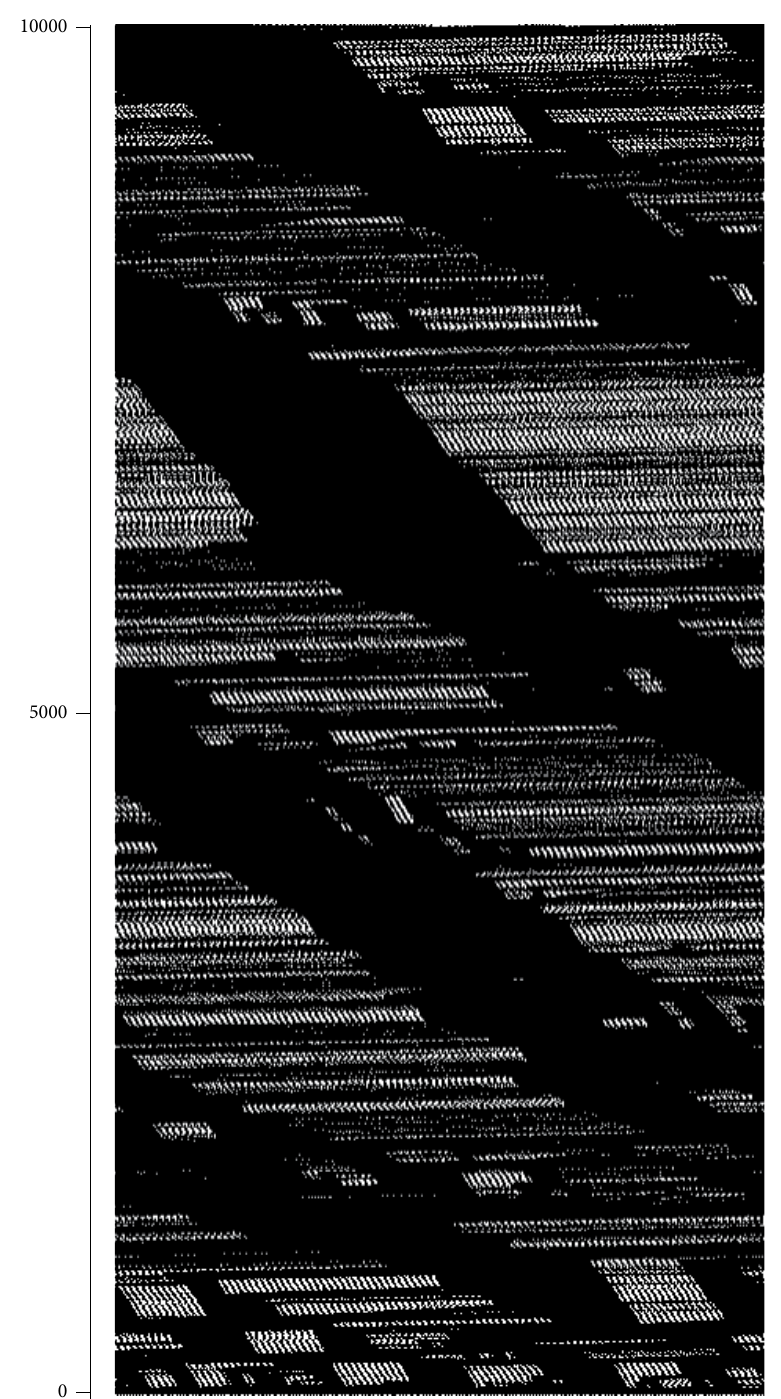
Figure 2: Illustration of vehicle positions over 10,000 time steps for the multi-state NS model. Here, the vertical and horizontal axes indicate the time step and vehicle position, respectively, and each vehicle is shown as a black dot. The vehicle density is 0.40, 𝑝 = 0.01 , v max = 5 , threshold_slow = 5, and threshold_acceleration =